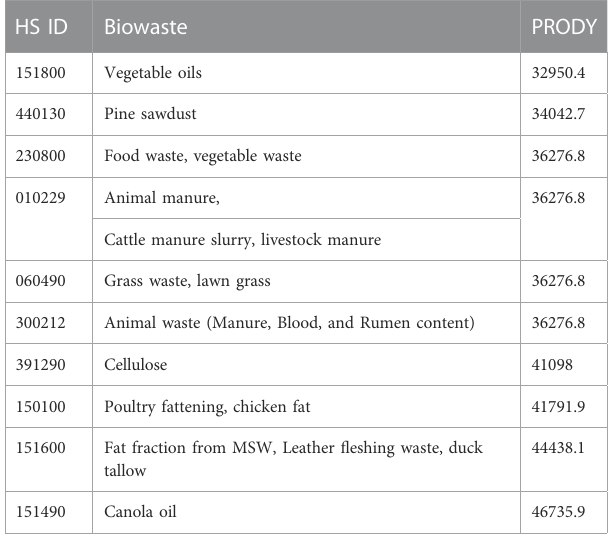
TABLE 3 High-Income Potential (HIP).